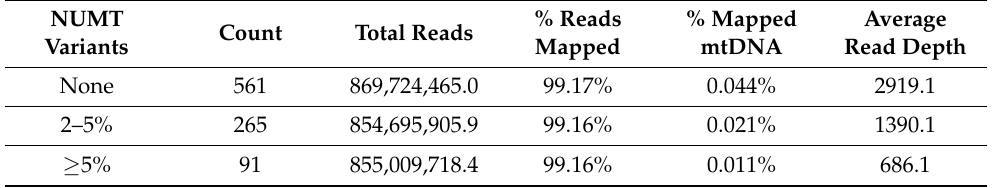
Figure 5. Distribution of average read depth based on the detection of NUMT interference at either a 2% frequency threshold or 5% frequency threshold. The sample count per NUMT variant observation category is noted in parentheses for each category. The average for each classification is shown as an “×” and outliers are shown as single data points. Table 2. Average analysis metrics of passing samples depending on the observation of NUMT variants in the mtDNA data. The “% Mapped Reads” is the proportion of total reads that mapped to the GRCh37 and the “% mtDNA Reads” is the proportion of the mapped reads that aligned to the mitochondrial reference